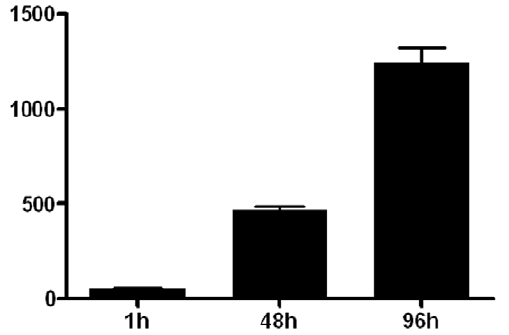
Figure 2. Intracellular replication of R. prowazekii in 3T3-L1 adipocytes. Adipocytes were infected with R. prowazekii (bacterium- to-cell ratio of 50:1) for 1 hour, washed and cultured for 2 and 4 days. Infection was measured by immunofluorescence. Results represent mean values ( 6 SD) of 3 experiments.